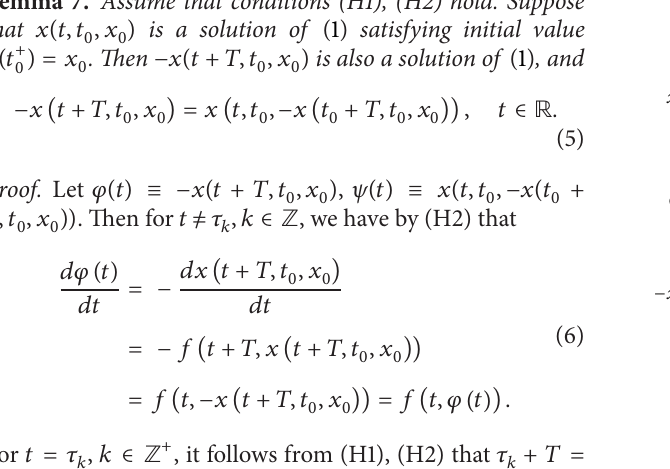
two elements (𝑡 0 , 𝑥) and (𝑡 0 + 𝑇, −𝑥) on 𝐷 as the same point (or sticking (𝑡 0 , 𝑥) and (𝑡 0 + 𝑇, −𝑥) together). Thus 𝑀 2 is a surface with only one side or the well-known Moebius stripe